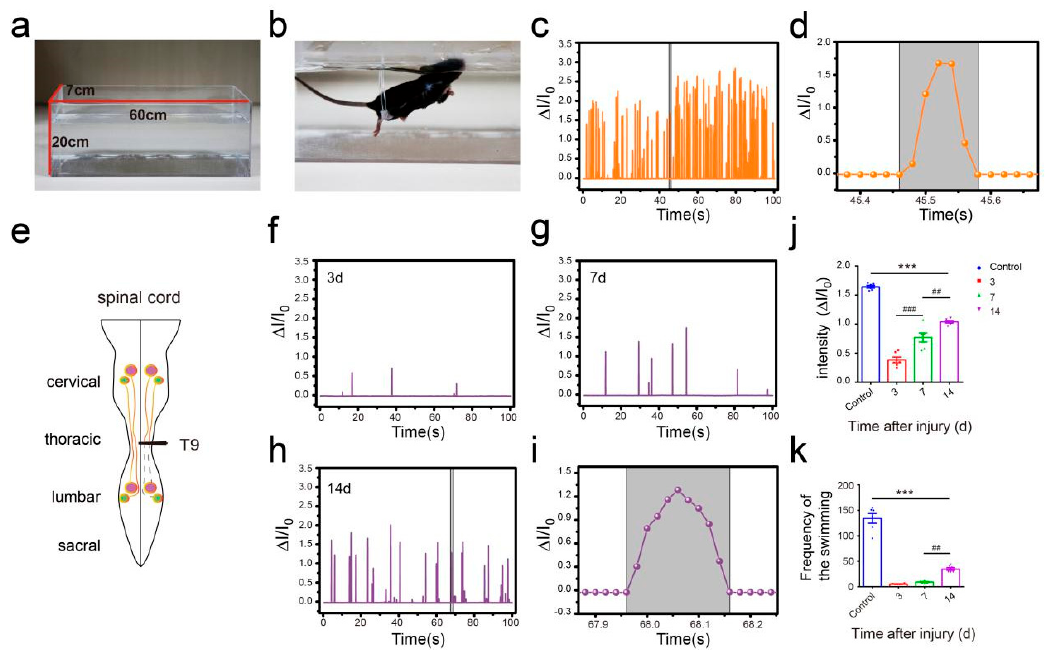
Figure 9. Hindlimb locomotion during swimming. ( a ) Plexiglas box for swimming. ( b ) intact mouse swimming. ( c ) Hindlimb locomotion of intact mouse and its corresponding relative current. ( d )